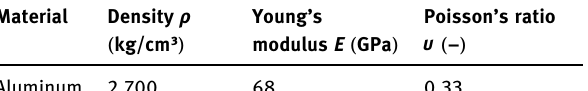
Table 1: Material properties for the aluminum Material Density ρ